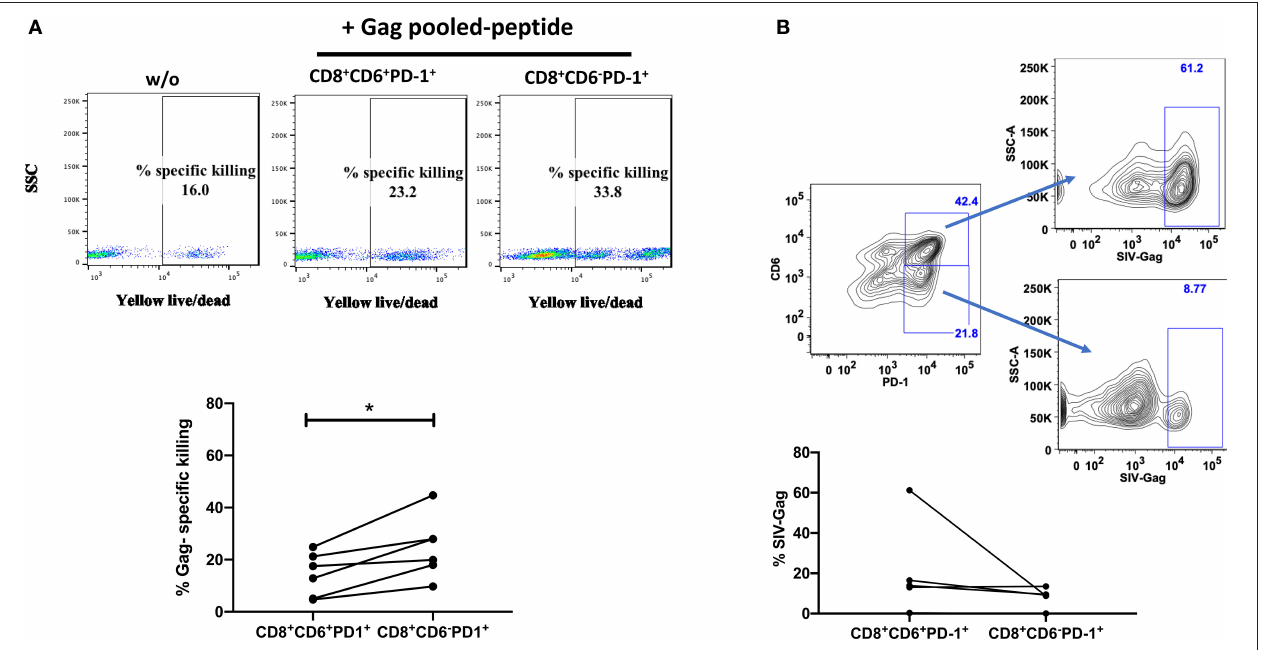
FIGURE 6 | Overexpression of CD6 and PD-1 is associated with reduced cytotoxicity. (A) Representative staining of Gag-specific killing of autologous CD4 + T-cells by splenic CD8 + CD6 + PD-1 + and CD8 + CD6 − PD-1 + T-cells with and without pooled Gag peptides and the overall killing frequencies calculated as the peptide-stimulated response minus the unstimulated response. Data are from 6 macaques. (B) Representative staining and frequency of SIV-specific CD8 + T cells within the sorted splenic CD3 + CD8 + CD6 + PD-1 + and CD3 + CD8 + CD6 − PD-1 + T-cells. SIV-specific CD8 + T cells were detected by CM9 (Gag, CTPYDINQM; residues 181-189 FITC) dextramer staining. SIV-specific cells are defined as CM9 + . Data are from 5 macaques. Data are shown as means ± SEM. For statistical analysis, Mann-Whitney tests were performed. * p <